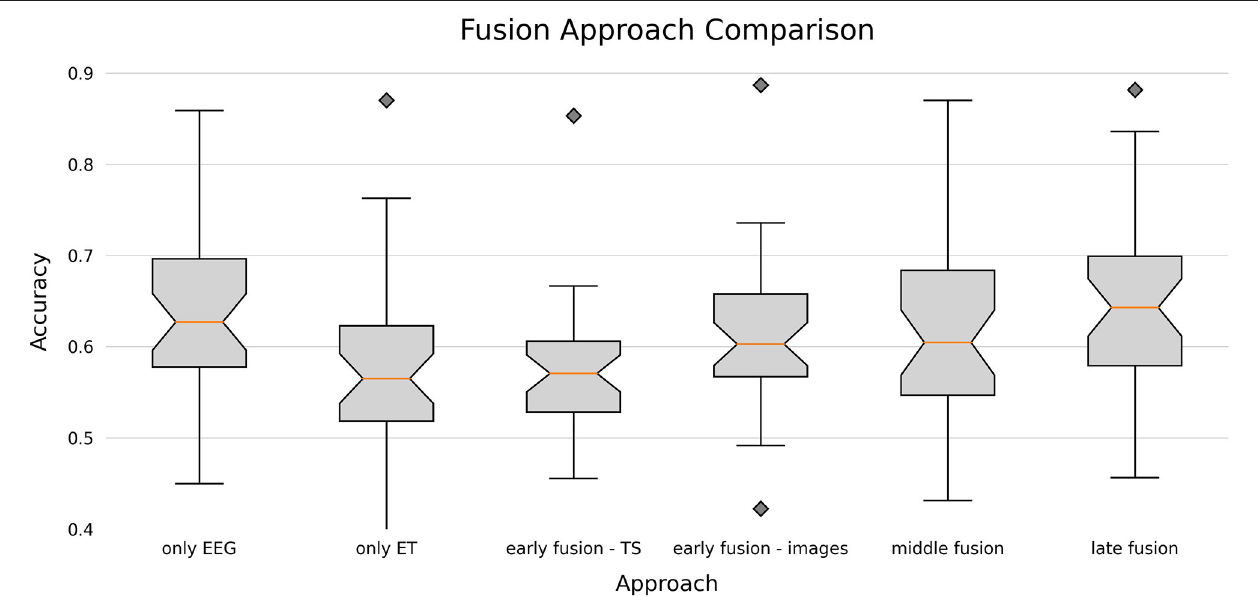
FIGURE 5 | Boxplots for the classification accuracies of the different fusion approaches visualizing the lower to upper quartile values of the data, with a line at the median. The whiskers represent the 95% range of the data. Diamonds represent